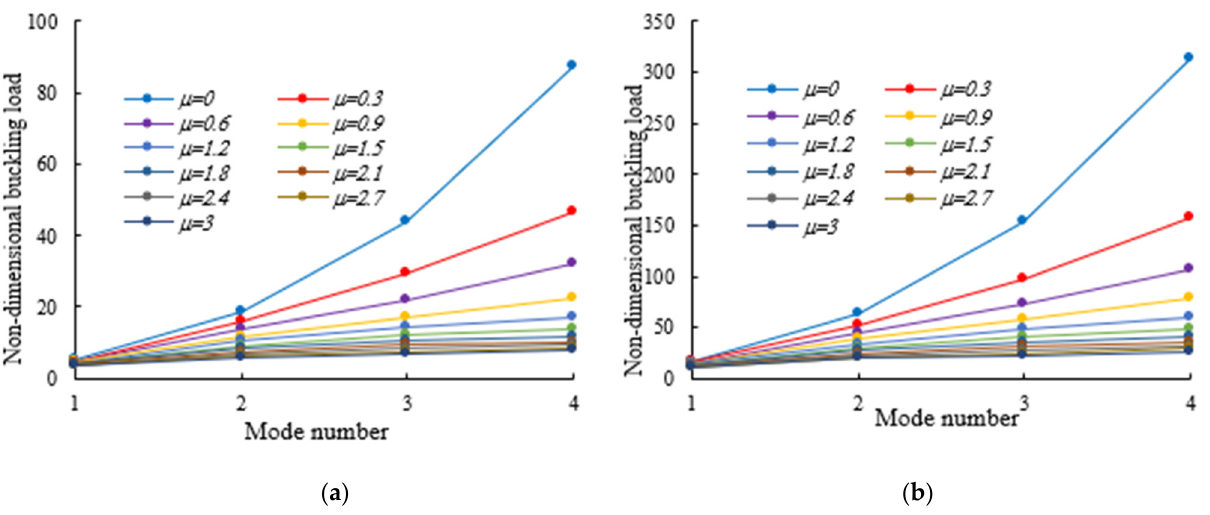
Figure 11. Effects of Eringen’s nonlocal parameters on the flexural–torsional buckling load of doubly symmetric I-section nanobeams under a compressive axial load on the TF at x = 0: ( a ) α = β = 0; m = 1; ( b ) α = β = 0.5;